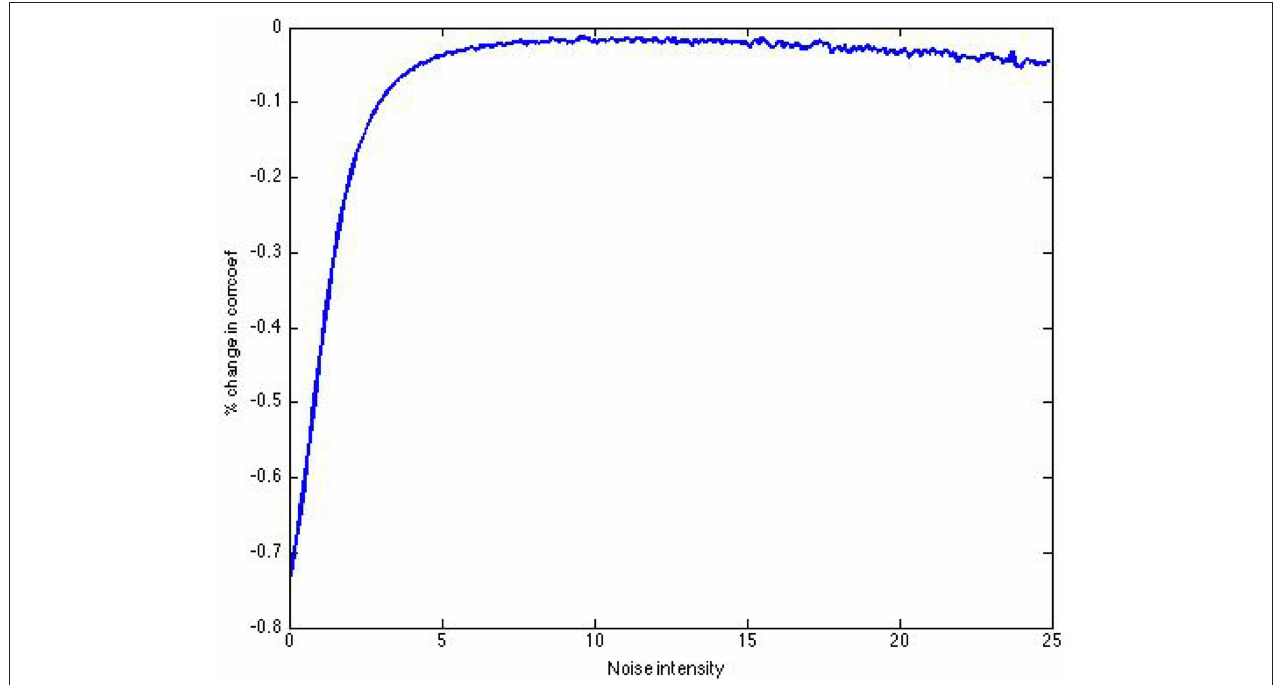
FIGURE 17 | Post-SSR increase in correlation coefficient using 10,000 threshold units, over 3000 time units.